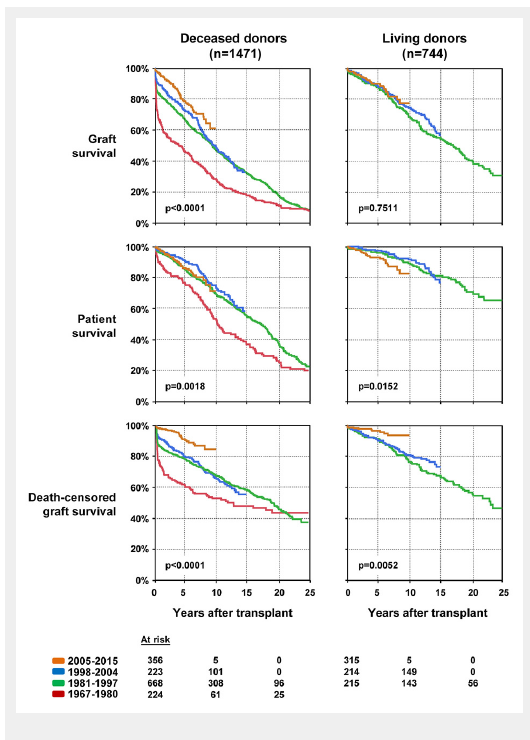
Evolution of graft survival, patient survival and death-censored graft survival, grouped by the donor source (living vs deceased). Due